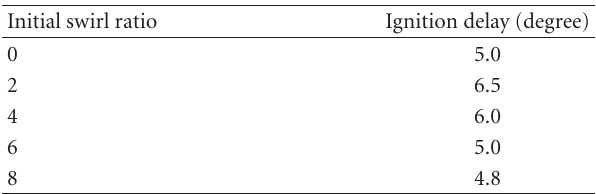
Figure 6: (a) E ff ects of intake temperature and pressure on knock occurrence (T-in = 380 ◦ K and P-in = 2.8 bar) and (b) e ff ect of intake temperature and pressure on knock occurrence (T-in = 430 ◦ K and P-in = 3.8 bar), predicted by KIVA3V. Table 4: E ff ect of initial swirl ratio on ignition